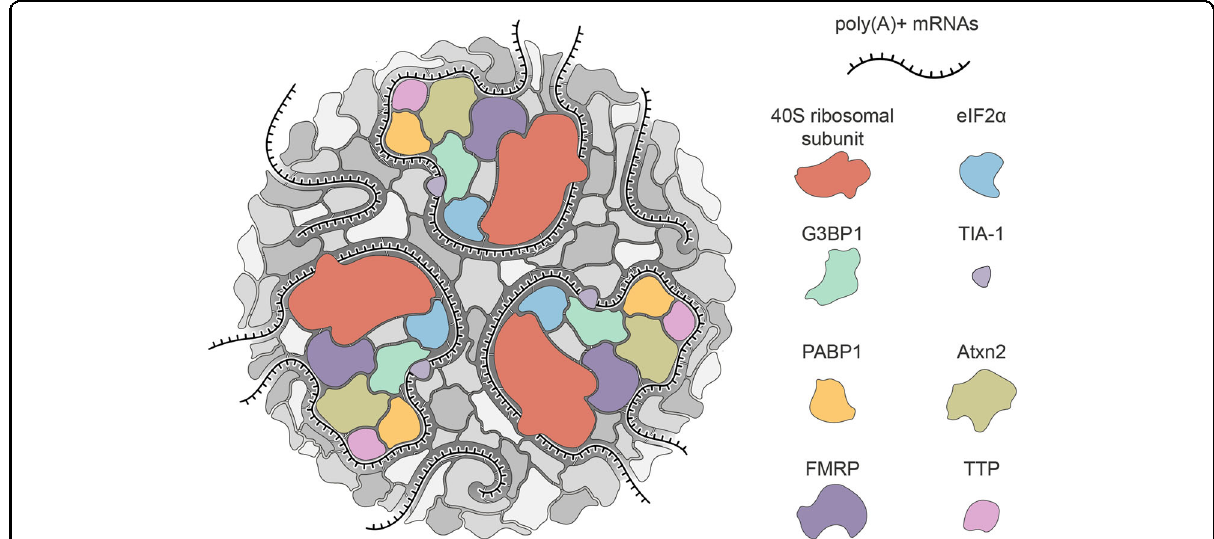
Fig. 1 Stress granule components. Stress granules are multimolecular cytoplasmic foci that assemble as part of the cellular response to stress. They largely derive from stalled pre-initiation translation complexes and are mainly comprised of poly(A) + mRNA molecules, 40S ribosomal subunits and a vast array of proteins (more than 450). The majority of these are RNA-binding proteins (RBPs) that bind to each other and to the other SG components. They include eukaryotic translation initiation factor 2 subunit alpha (eIF2 α ), ras GTPase-activating protein-binding protein 1 (G3BP1), T-cell intracellular antigen-1 (TIA-1), polyadenylate-binding protein 1 (PABP1), ataxin-2, fragile X mental retardation protein (FMRP) and tristetraprolin (TTP). The unspeci fi ed shapes coloured in grayscale represent the remaining proteins counted among the numerous SG protein components described so